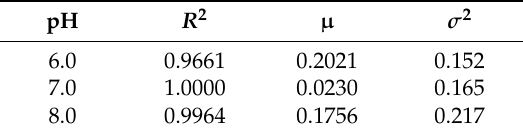
Figure 4. The average HA radius of gyration as a function of DPPC concentration defined as the mass ratio k PL : HA = PL . The lines represent Gaussian function fitting to mean values (represented by stars). The fitting parameters are presented in Table 1. The legend indicates pH values. Table 1. Gaussian function fitting parameters for Figure 4. R 2 is the coefficient of multiple determinations for regression, which ranges from 0 to 1 and measures how close the data are to the fitted regression and how well the observed outcomes are replicated by the model. µ is an expected value, also known as the expectation, average, mean value, or first moment; and, σ 2 is an expectation variance value of the squared deviation of a random variable from its mean, also informally measuring how far a set of numbers are spread from their mean.